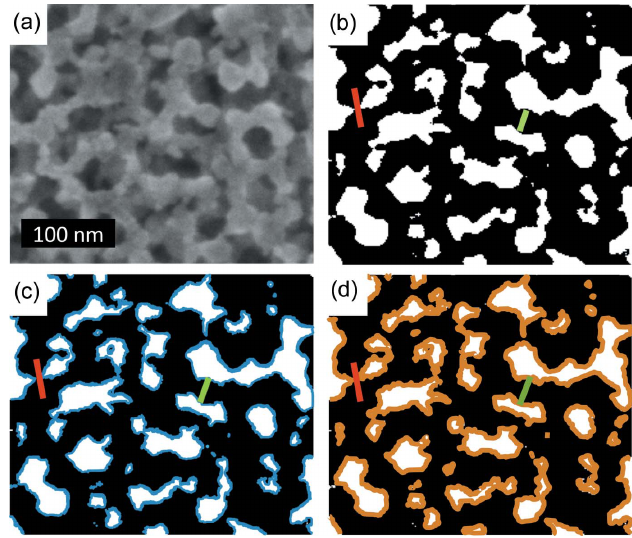
Figure 5 Schematic representation of the material infiltration model into a mesoporous titania matrix. ( a ) Grayscale SEM image of as-prepared mesoporous titania and ( b ) binarized SEM with structure size (2 (cid:5) FF 1 , green bar) and distance (SF 1 , red bar) as extracted from ToF-GISANS modeling for as-prepared mesoporous titania. SEM images with the respectively growing structure sizes (2 (cid:5) FF 1 , green bars) and constant distances (SF 1 , red bars) upon pore infiltration with ( c ) PTB7-Th represented in blue and ( d ) PhenTe-BPinPh represented in orange. The simulated blue and orange representations of PTB7-Th and PhenTe- BPinPh are added for visualization. green bar in Fig. 5( b ) represents the cylinder diameter (FF (cid:5) 2) and the red bar represents the center-to-center prepared